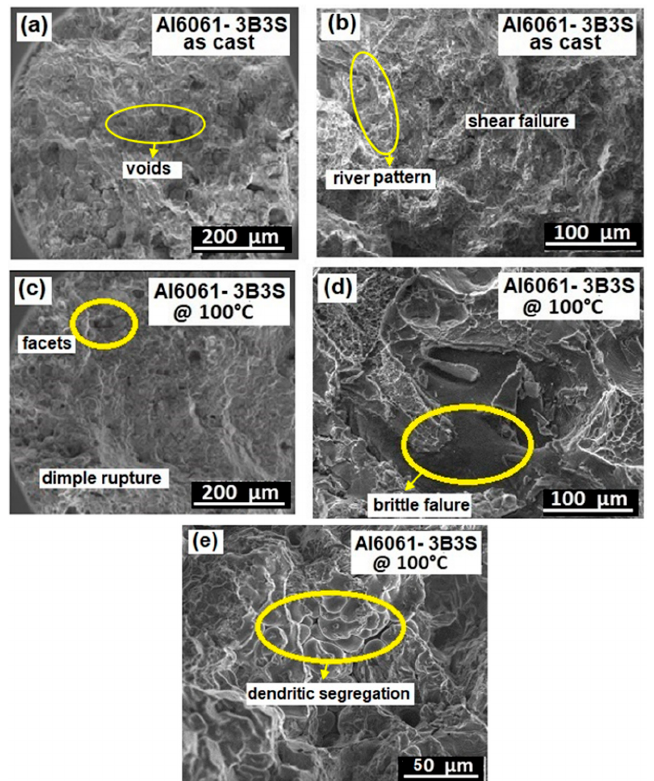
Figure 12. SEM fractographs of as-cast ( a ) Al6061-3B3S hybrid composite ( b ) at higher magnification. ( c ) Al6061-3B3S hybrid composite peak-aged at 100 °C. ( d , e ) Different locations at higher magnification.